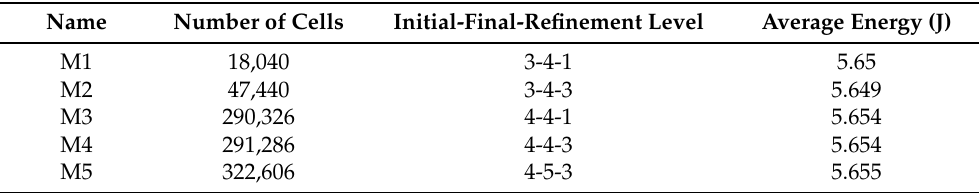
Table A3. Mesh parameters. The initial-final-refinement level indicates how refinement evolves on the different mesh parts. Larger values indicate more refinement. The first and second digits indicate the two levels of refinement closest to the foil surface. the last digit indicates how many levels of refinement exist in the refinement box (large square containing the foil in Figure 2. The test parameter was energy output averaged through a large number of cycles (more than